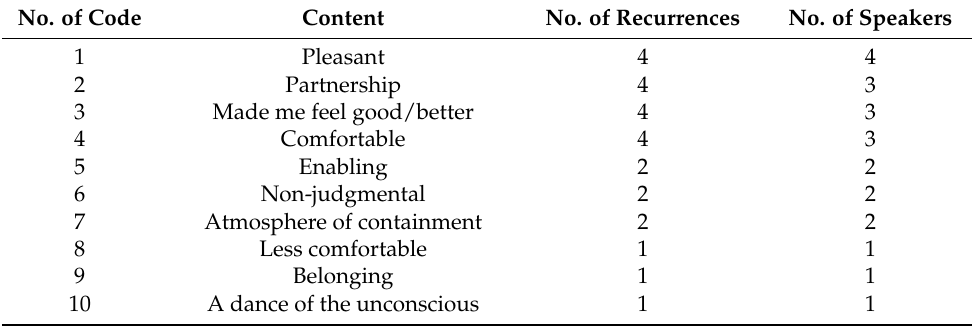
Table A6. Category F: Being a member in the present